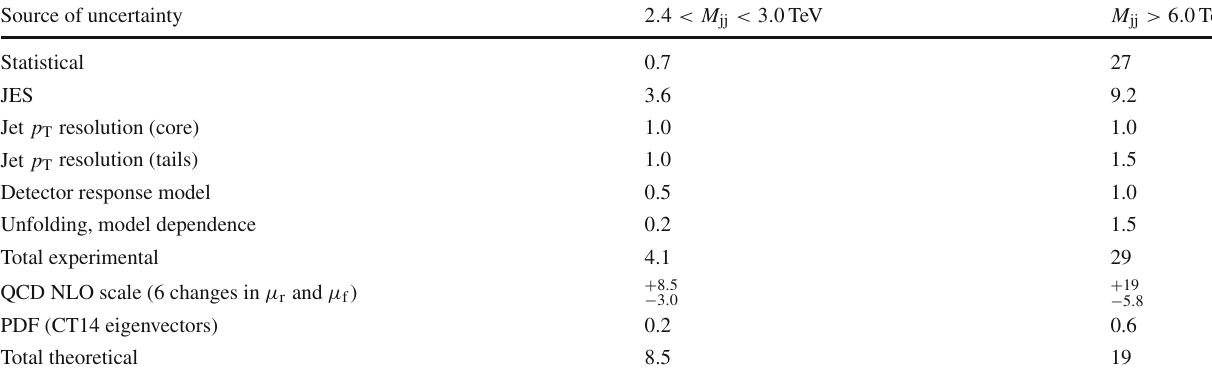
Table 1 Summary of the leading experimental and theoretical uncer- taintiesinthenormalized χ dijet distributions,inpercent.Whilethestatis- tical analysis represents each uncertainty through a change in the χ dijet distribution correlated among all χ dijet bins, this table summarizes each uncertaintybyarepresentativevaluetoshowtheirrelativecontributions.